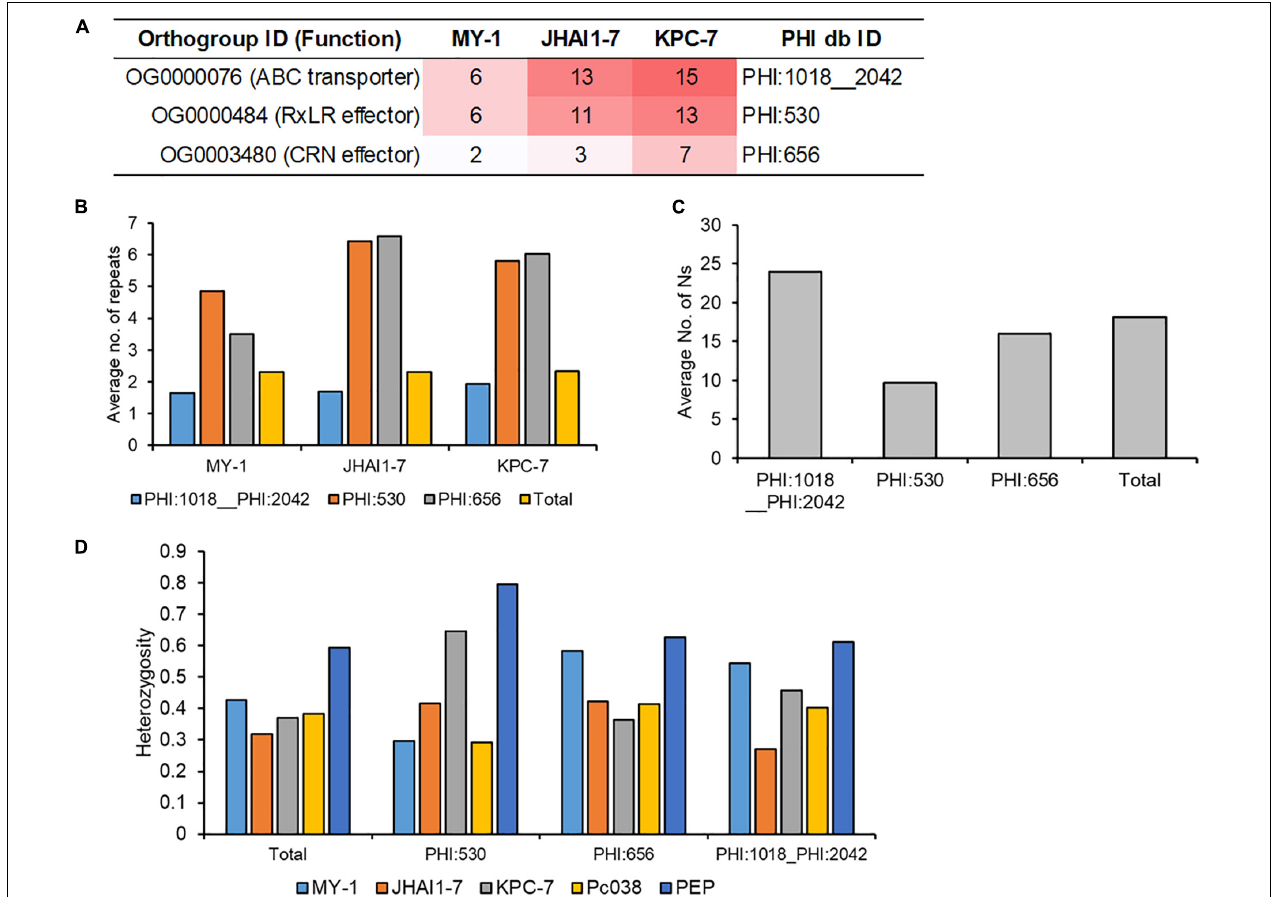
FIGURE 5 | Genomic and reseqeuncing evidence for the evolution of the agressive isolates. (A) The number of protein families (corresponding to the expanded gene families) in three isolates. The number of protein families is represented by the color intensity from white (low) to red (high) color. Three protein families in plant-host interaction (PHI) database were represented by PHI ID (PHI:1018__2042: ABC3; PHI:530: Avr1b RxLR effector; crn1 CRN effector. (B) The number of repeat elements around 2.3 kbp (average distance of genes) in each protein family where total genes represent all annotated genes. (C) The number of disruptive SNPs in each gene family where total genes represent all annotated genes. (D) Heterozygosity levels in each gene family where total genes represent all annotated